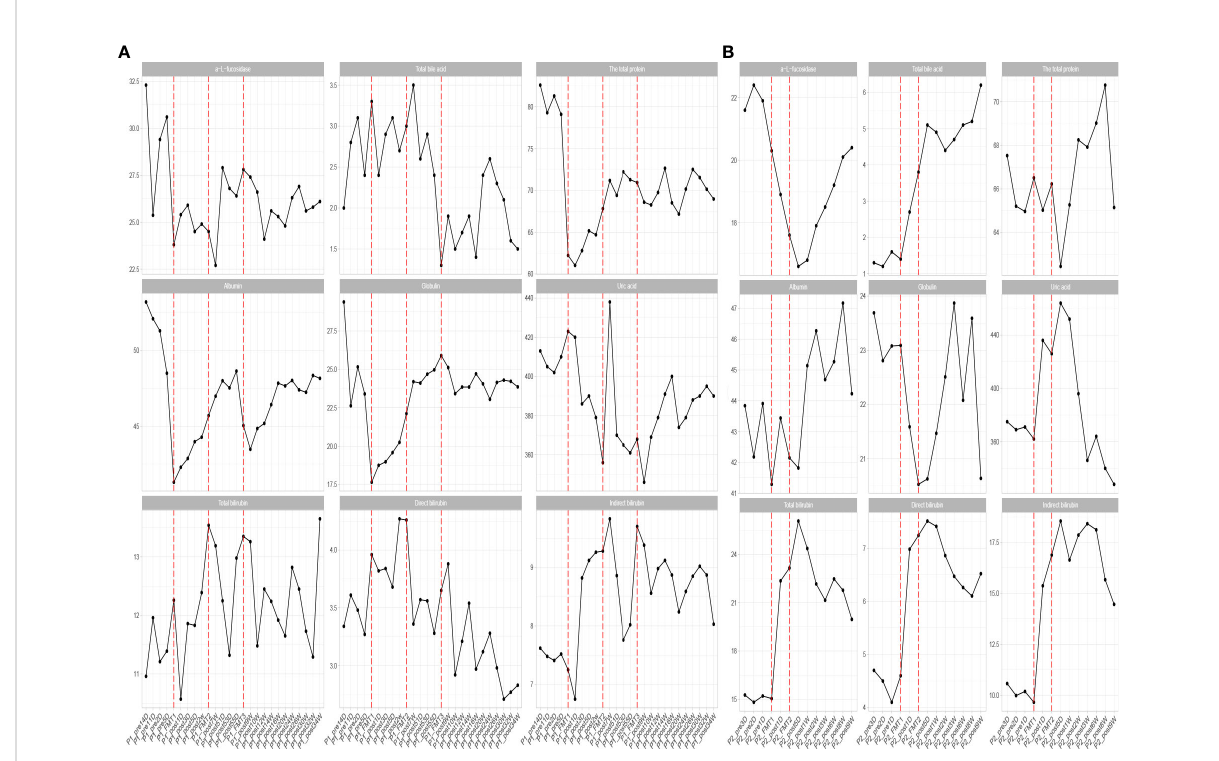
FIGURE 3 Changes in biochemical parameters before and after transplantation in Patients 1 (A) and 2 (B) . The horizontal coordinates in the graph indicate the different time points before and after the transplantation of the patient. The verticalcoordinates are the corresponding values of biochemical related indexes at different time